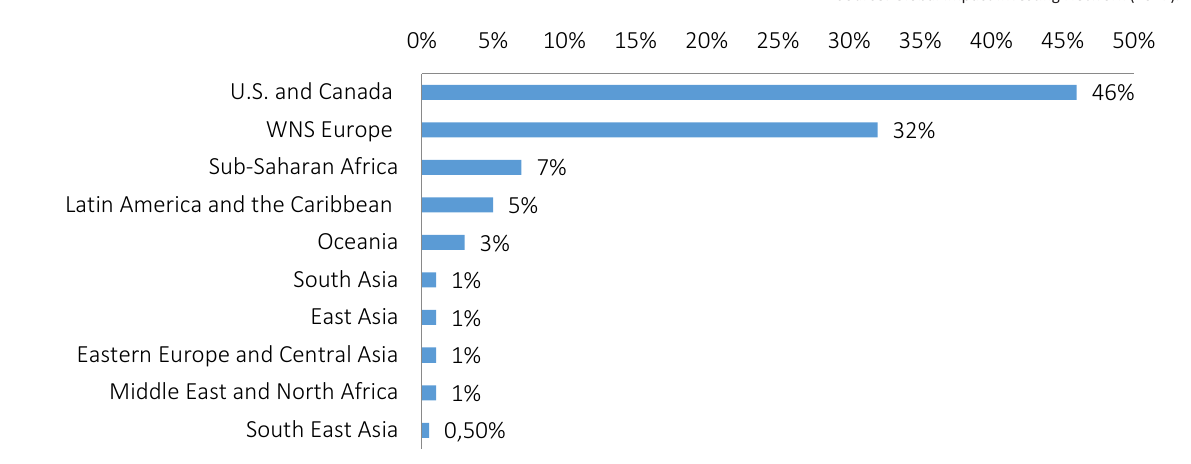
Figure 1. Geographical location of social investors (headquarters) under the GIIN